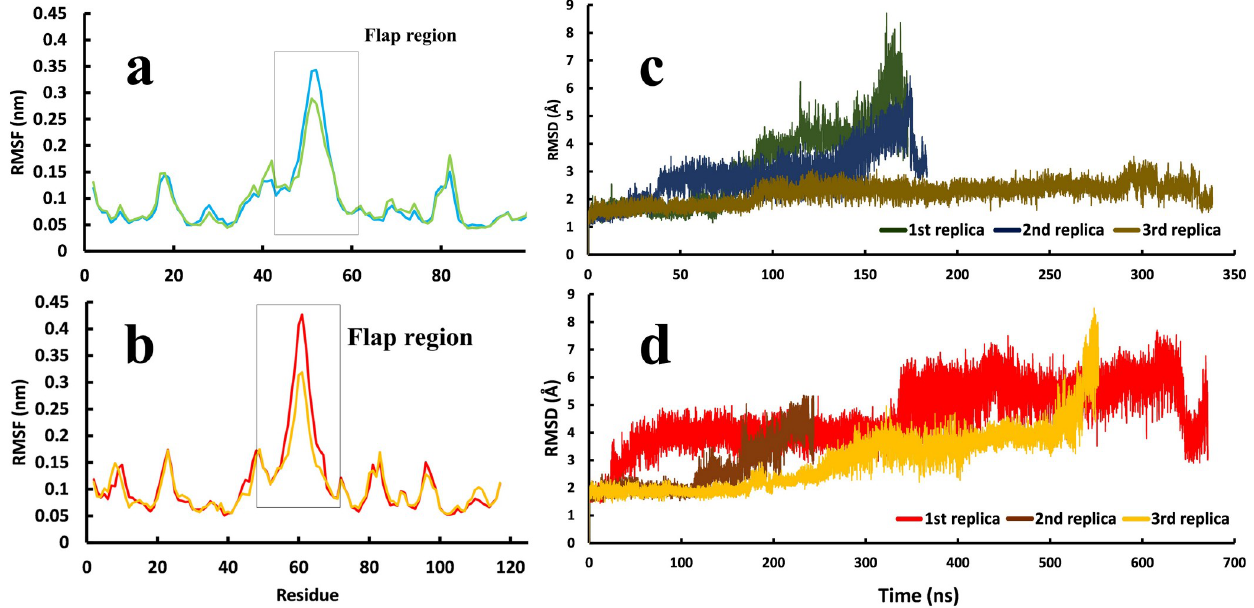
Fig 6. The average RMSF values of residues and the RMSD values of the two proteases’ backbone atoms in three replicas. a, RMSF values of HIV protease and, b, RMSF values of HTLV-1 protease. c, RMSD values of the backbone atoms of HIV protease and, d, RMSD values of the backbone atoms of HTLV-1